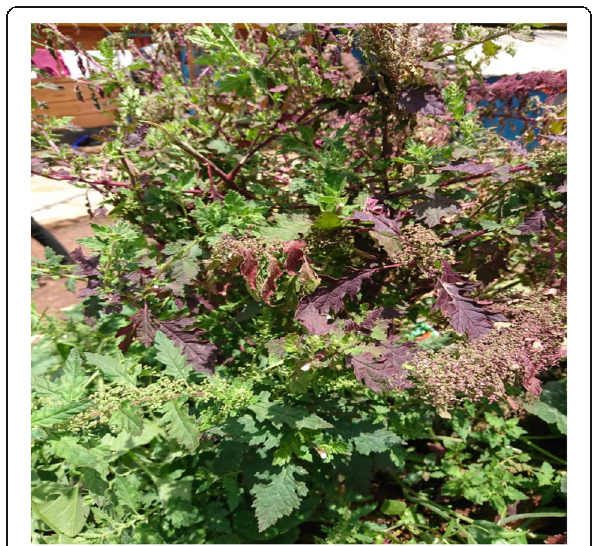
Fig. 1 Photo of Chenopodium ambrosioides L. (Taken in Bukavu, Democratic Republic of